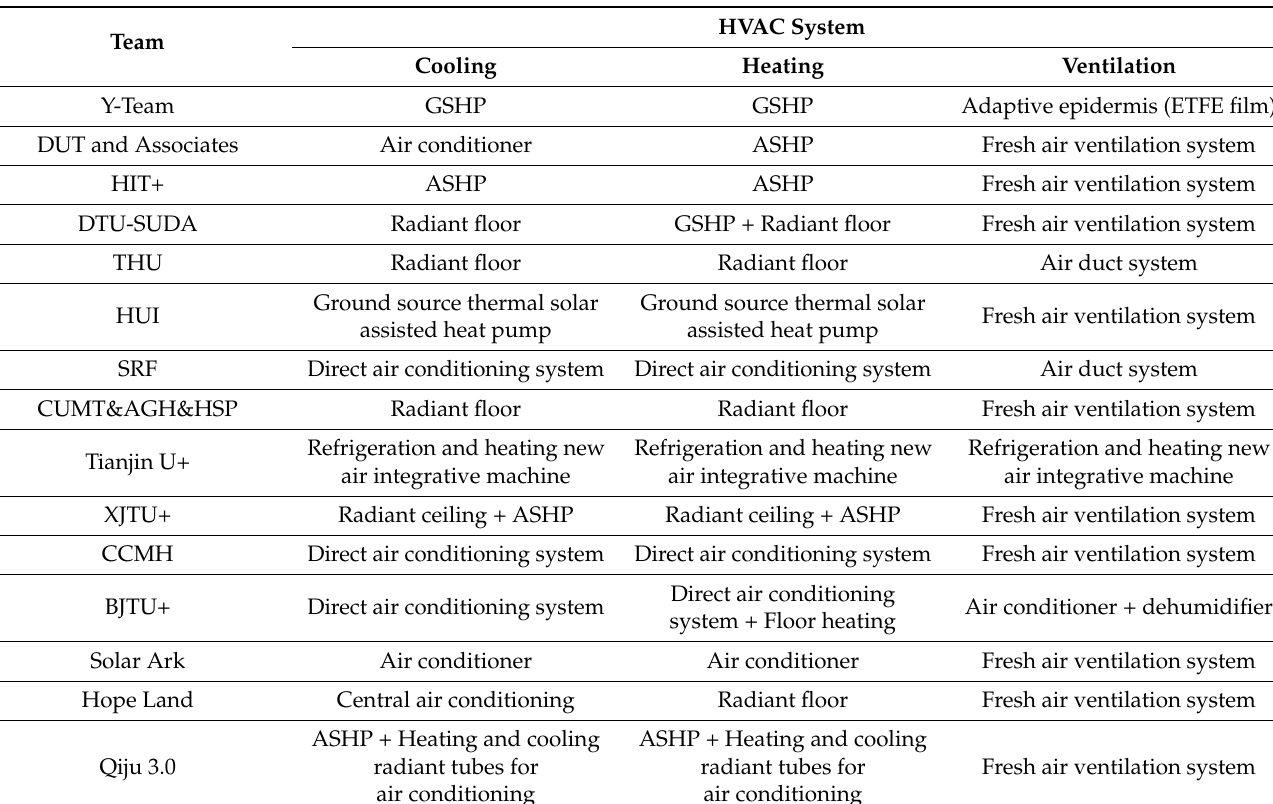
Table 6. Application of HVAC